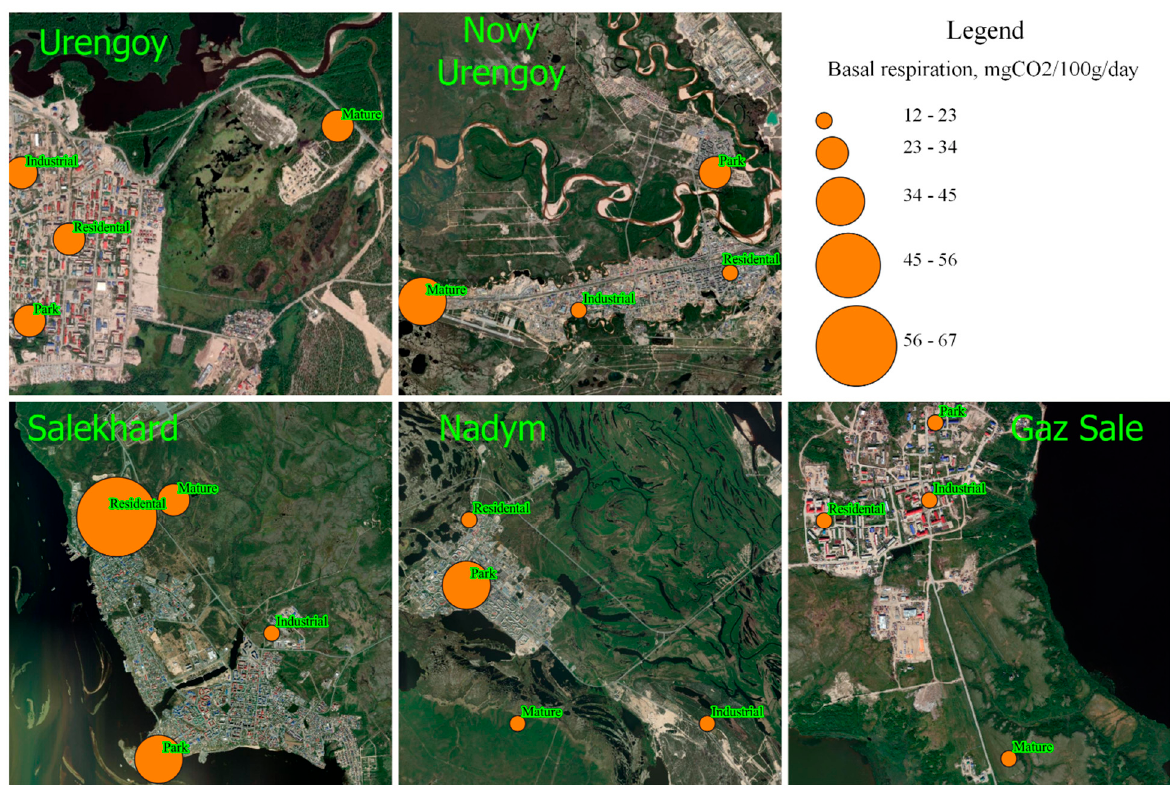
Figure 4. Level of soil basal respiration in the studied soils.